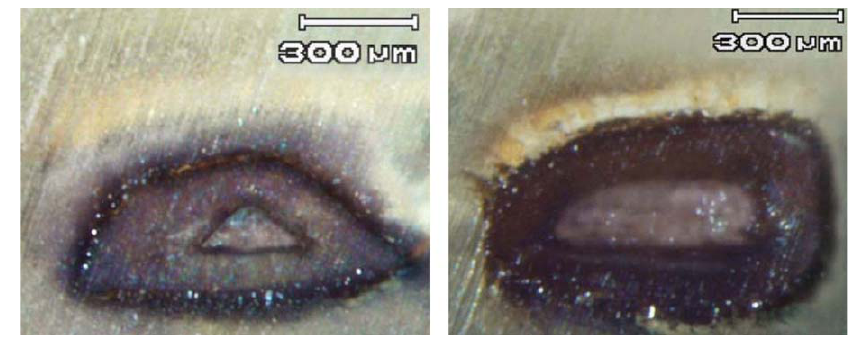
Fig. 6. Claw’s cross-section.